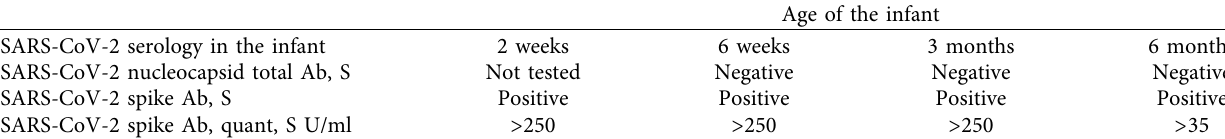
Age of the infant